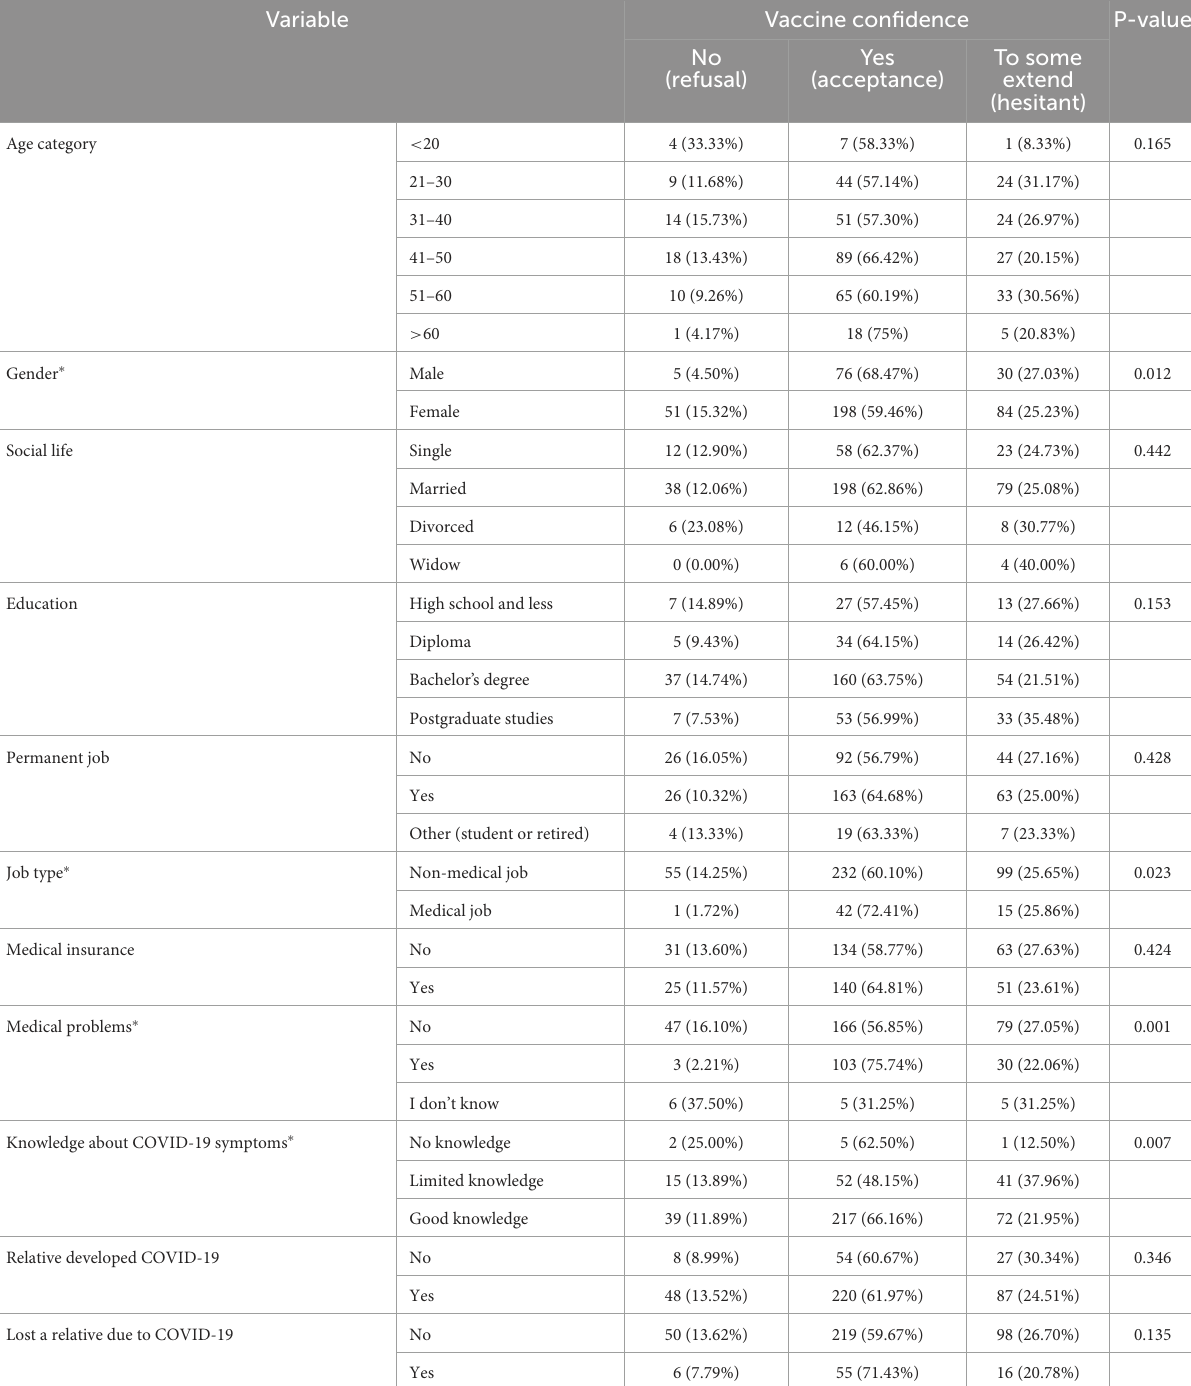
TABLE 3 The frequency distribution and chi-squared analysis of demographic characteristics and vaccine-confident among different socio-demographic characteristics of the study population.